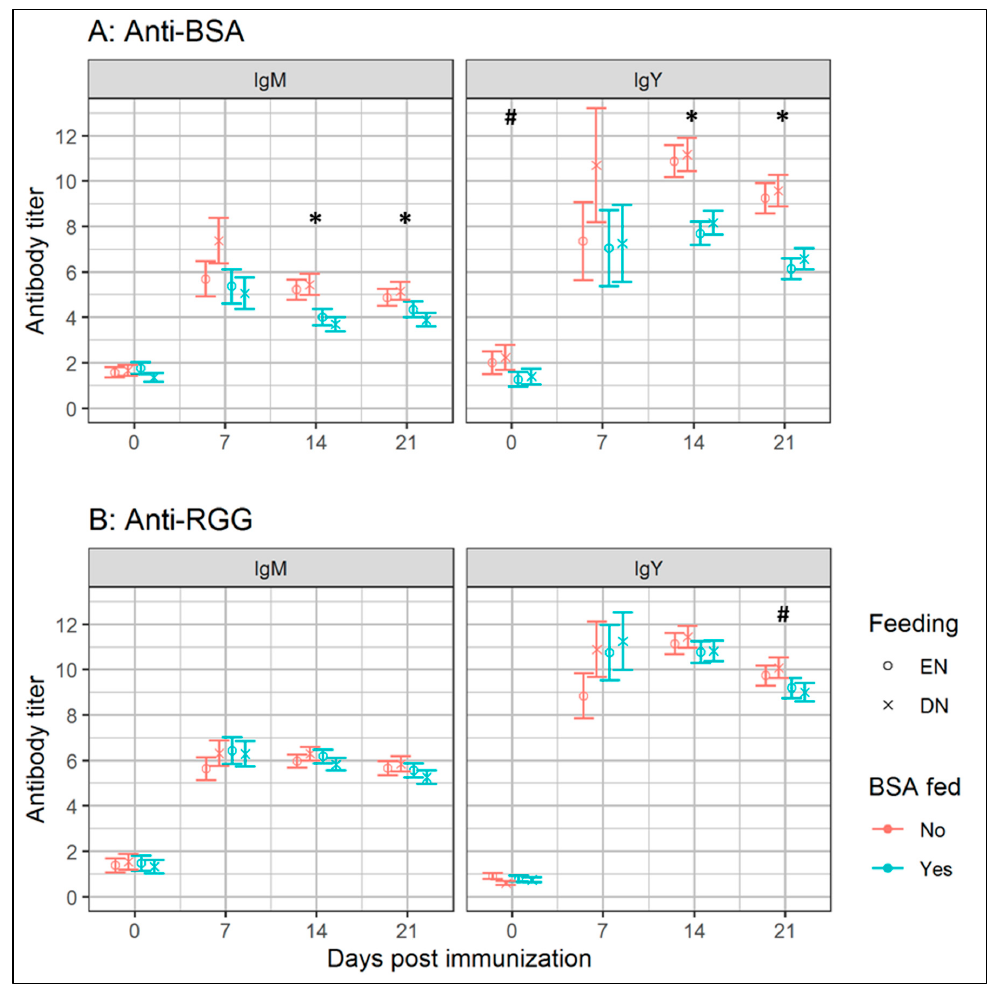
Figure 1. IgM and IgY binding bovine serum albumin (BSA; panel A ) or rabbit γ‐ globulin (RGG; panel B ) in the blood plasma of broiler chickens fed with BSA during the first 3 d of age, or not, and receiving either delayed (DN) or early nutrition (EN) in experiment I. Broilers were intratracheally immunized with BSA and RGG at 21 d of age (0 d p.i.). Data are presented as estimated marginal means, with the error bars representing the standard error. Within different ages, differences between means of BSA and PBS ‐ fed groups are indicated by * ( p ≤ 0.05) or # ( p ≤ 0.10). n = 13 replicate broilers, housed in groups of 4–5 broilers per pen for all groups, except for the EN ‐ BSA ‐ fed, where n = 12 replicate broilers.